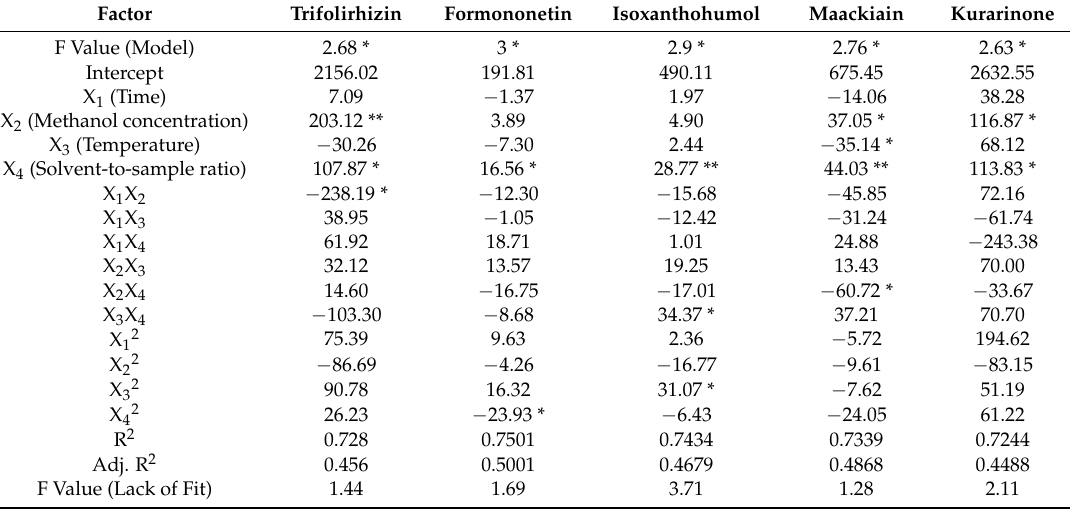
Figure 3. Response surfaces and contours plots of flavonoids extracted from Sophora flavescens : ( a ) extraction time (X 1 ) and methanol concentration (X 2 ); ( b ) extraction temperature (X 3 ) and solvent-to-material ratio (X 4 ); and ( c ) methanol concentration (X 2 ) and solvent-to-material ratio (X 4 ). Table 1. Regression coefficient, standard error, and analysis of variance (ANOVA) analysis of flavonoid extraction. Factor Trifolirhizin Formononetin Isoxanthohumol Maackiain